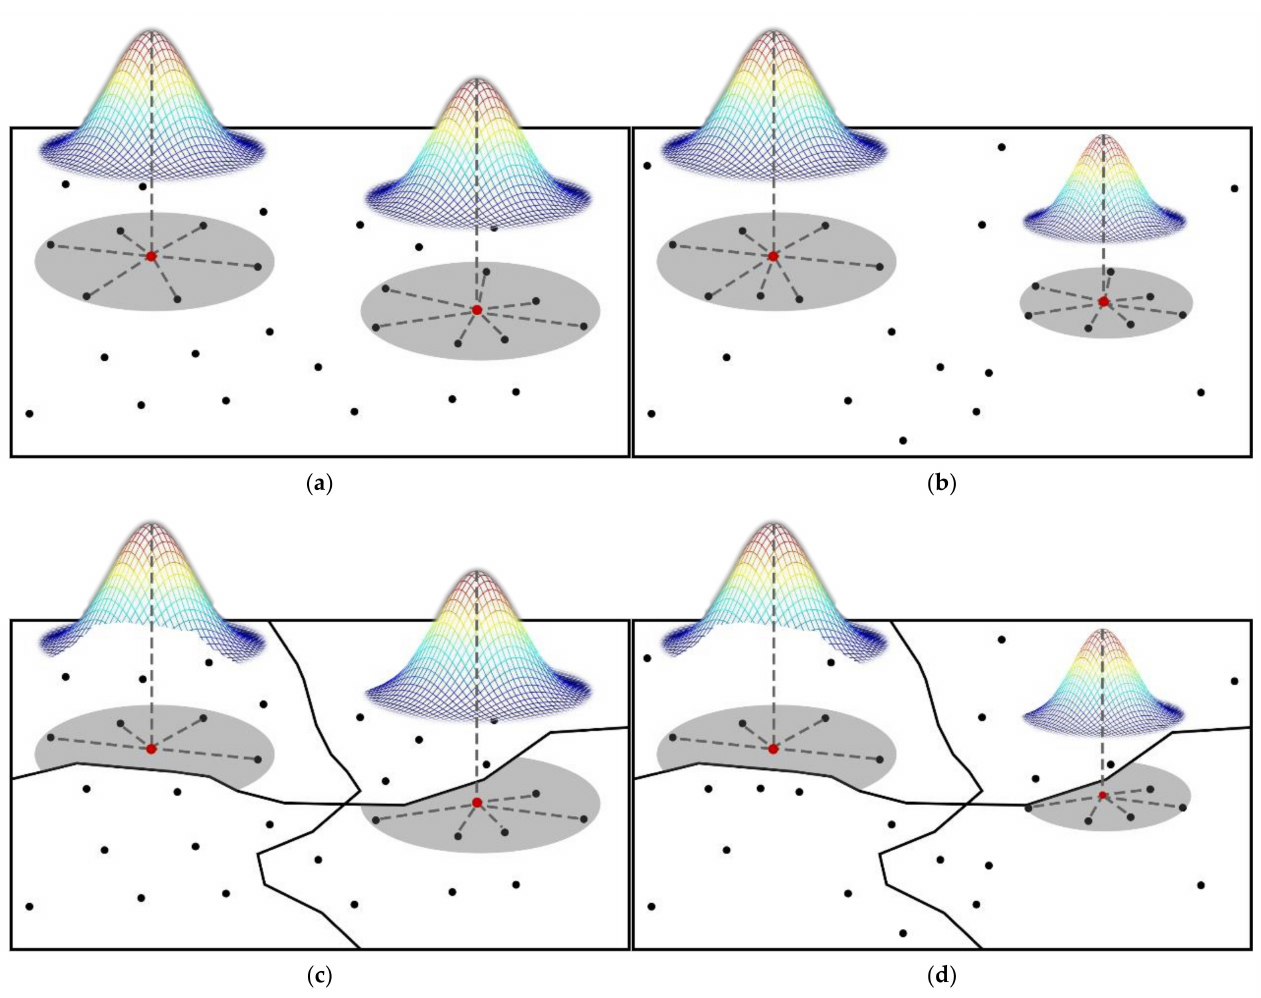
Figure 1. ( a ) GWR with fixed gaussian spatial kernels; ( b ) GWR with adaptive gaussian spatial ker- nels; ( c ) RGWR with fixed gaussian spatial kernels; ( d ) RGWR with adaptive gaussian spatial